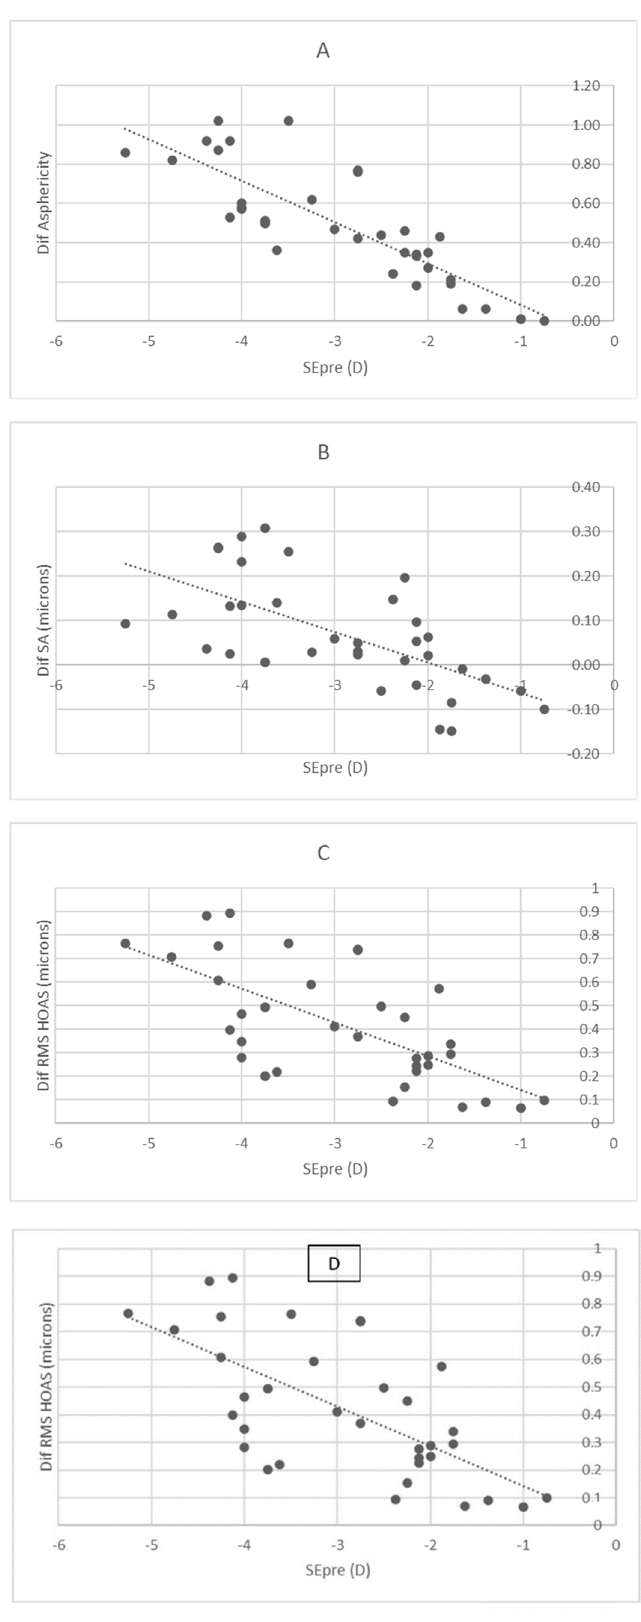
Figure 3. ( A – D ) Dispersion diagrams. Correlation between the preoperative SE and the difference between preoperative and postoperative values of asphericity ( A ), SA ( B ), RMS coma ( C ) and HOAS RMS ( D ).